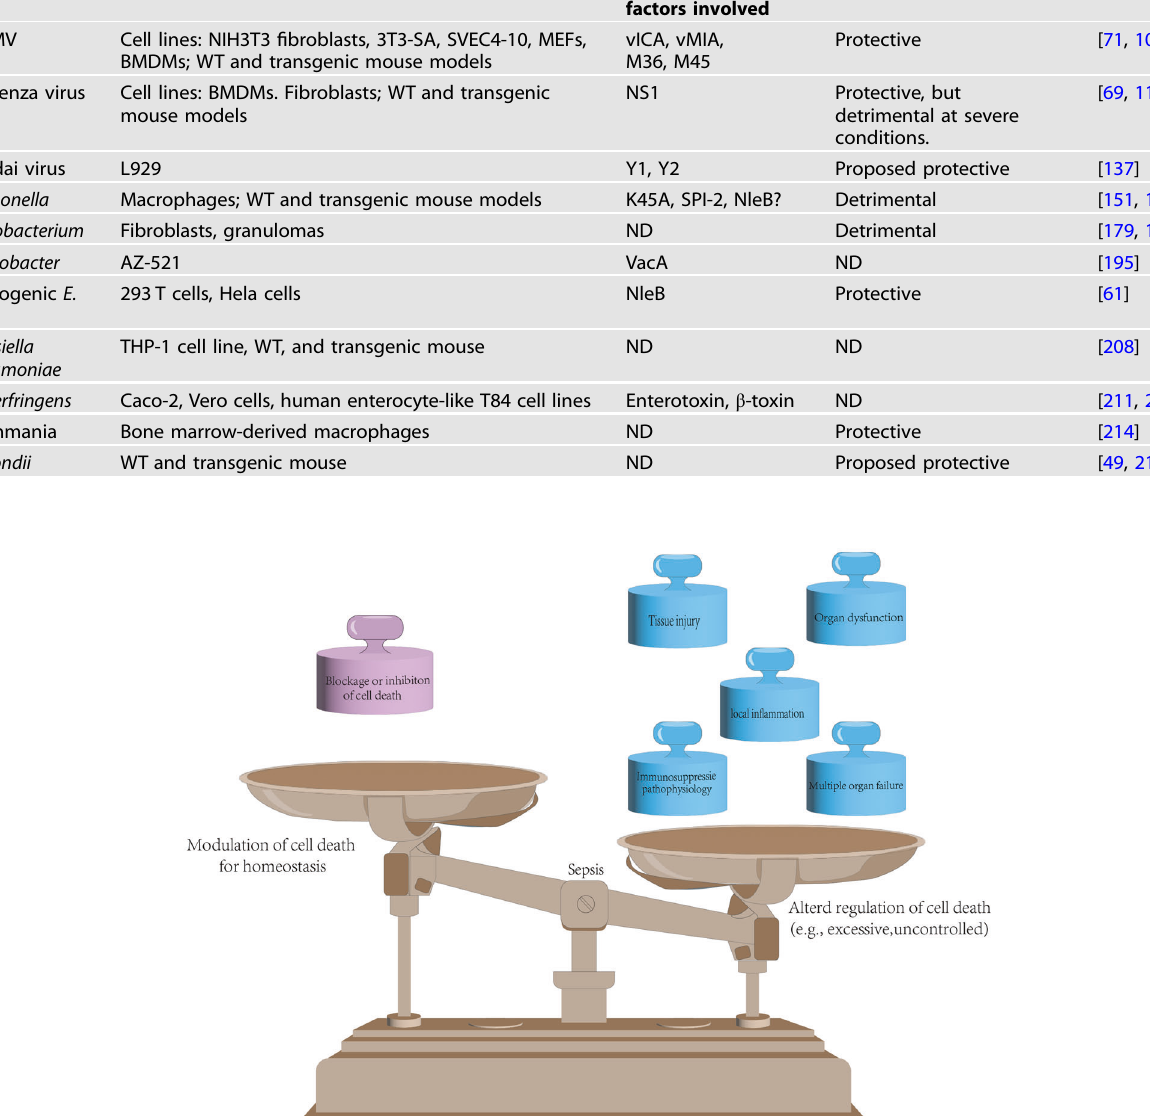
Table 1. Brief summary of necroptosis induced by common pathogens described in this review.